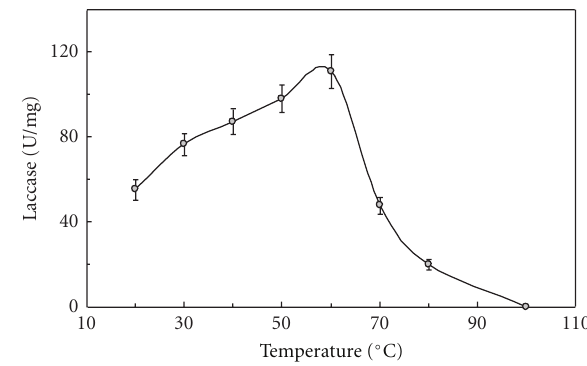
Figure 5: E ff ect of temperature on activity of Lentinus tigrinus